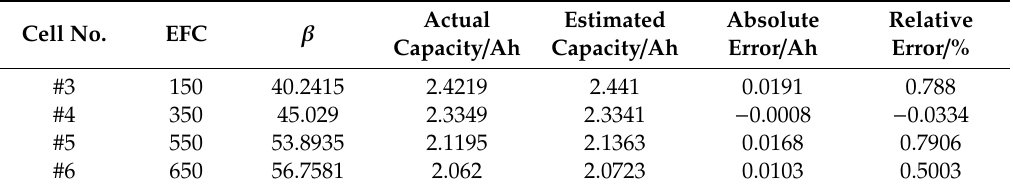
Table 6. Estimated results of β -based capacity estimation method at 40% SOC under discharging condition.